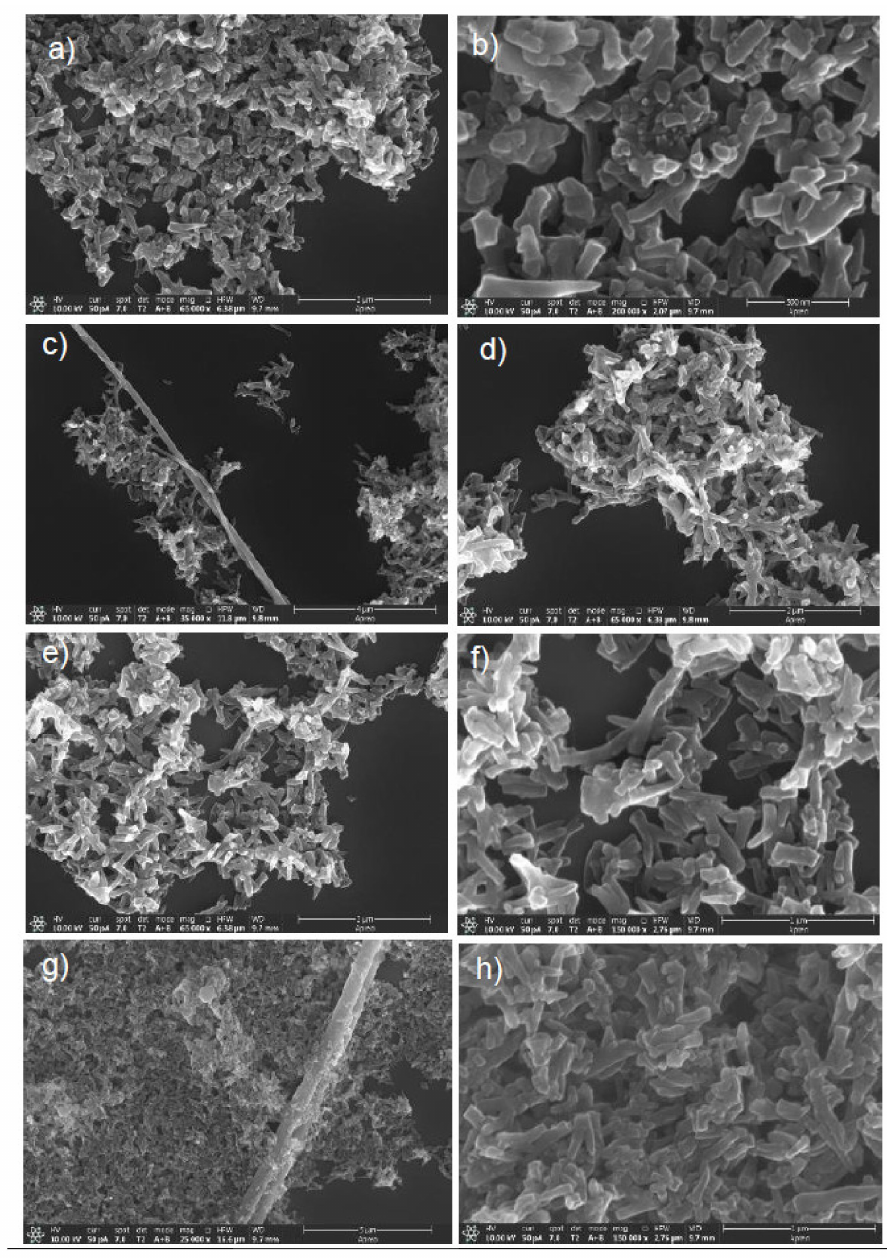
Figure 4. SEM images for representative polymers: ( a , b ) 1 ; ( c , d ) 2 ; ( e , f ) 3; ( g , h ) 4